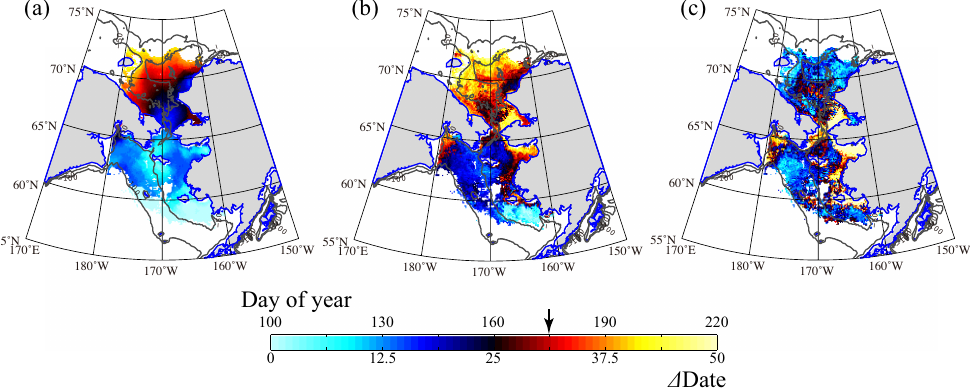
Figure 4. Distribution of 16-year median of (a) TSR, (b) date of CMAX, and (c) date difference between CMAX and TSR. Note that the colour scales of Fig. 4a and b are indicated on the upper tick marks of the colour bar, and the scale of Fig. 4c is indicated on the lower tick marks. The arrow on the colour bar denotes the date of the summer solstice (day of year: 174). Contours indicate 50m and 100m bathymetry